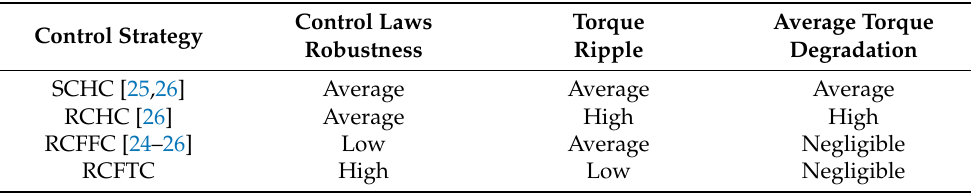
Table 4. Fault-tolerant control performances compared with literature results. Control